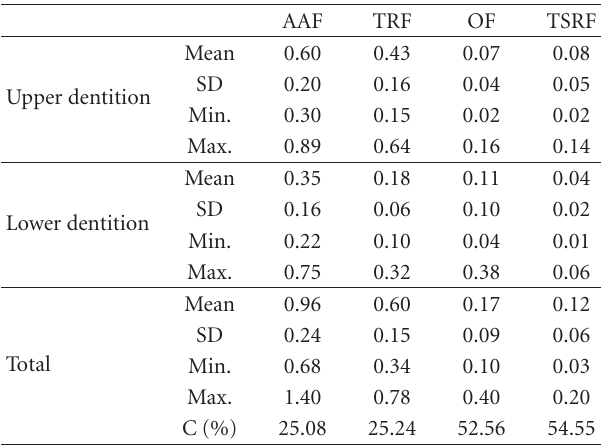
Table 3: Coe ffi cient of correlation between AAF and TRF, OF, and TSRF on deciduous and permanent dentition. AAF Deciduous dentition Permanent dentition r value P value r value P value TRF 0.9282 .0001 0.8717 .0010 OF 0.9042 .0003 0.7914 .0064 TSRF 0.1680 .6426 0.4243 .2216